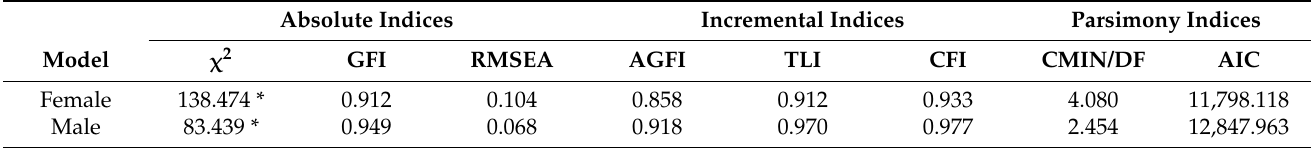
Table 6. Fit indices PASTAS- M10 for both